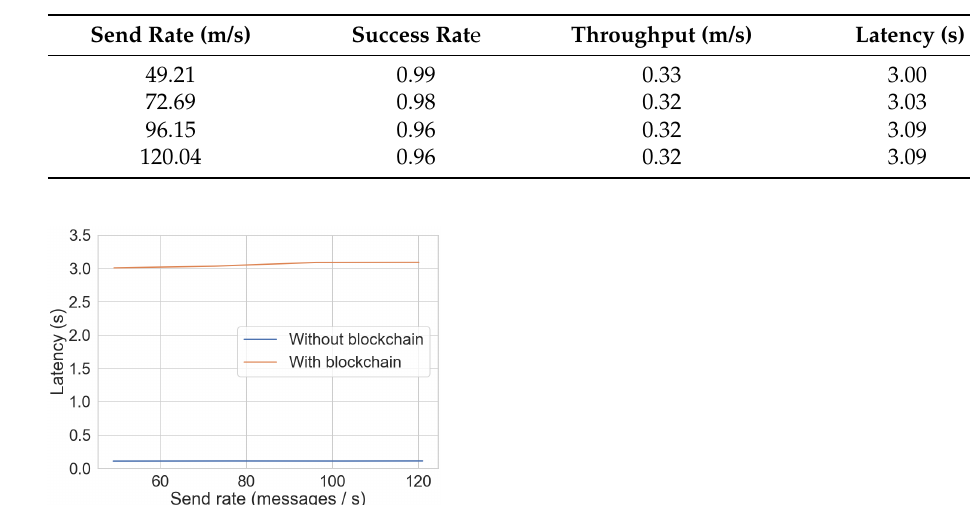
Table 2. Latency and throughput measurements with blockchain.